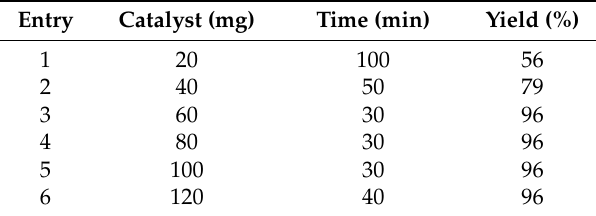
Table 3. Optimization of various weight % for the model reaction with 2.5% Ag 2 O/ZrO 2 catalyst a .